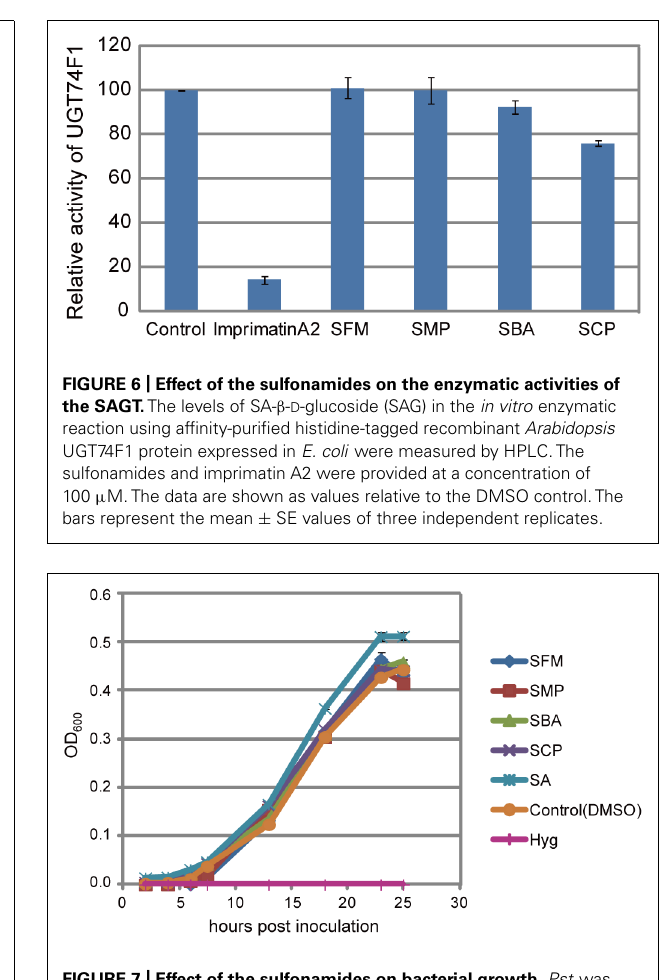
FIGURE 7 | Effect of the sulfonamides on bacterial growth. Pst was cultured in liquid minimal medium supplemented with 200 μ M of the indicated chemicals or 100 μ g/mL hygromycin, and bacterial growth was monitored as the optical density of bacteria at 600 nm at the indicated times after inoculation.The bars represent the mean ± SE values of three independent